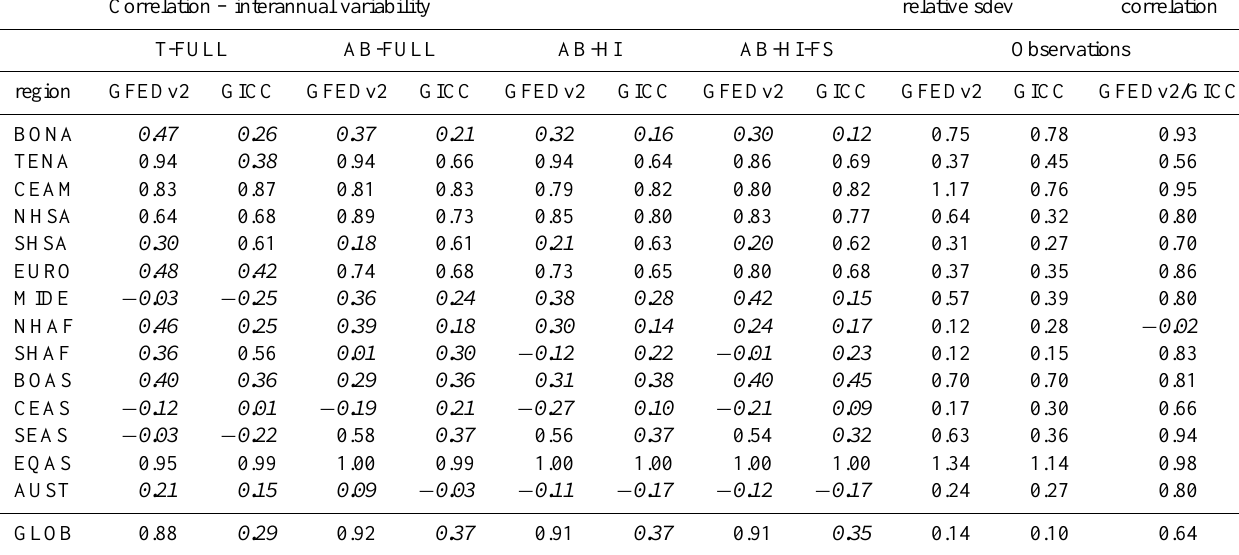
Table 4. Correlation coefficient for the interannual variability (1997–2004) between model simulations and GFEDv2 (van der Werf et al., 2006) and GICC (Mieville et al., 2010) for total (wildfire and deforestation) fire carbon emissions, relative standard deviation (relative sdev) of monthly fire carbon emissions for GFEDv2 or GICC, and the interannual correlation (correlation) between GFEDv2 and GICC. Non significant correlations (confidence level below 90%) are printed in cursive characters. Regions are defined in Fig.